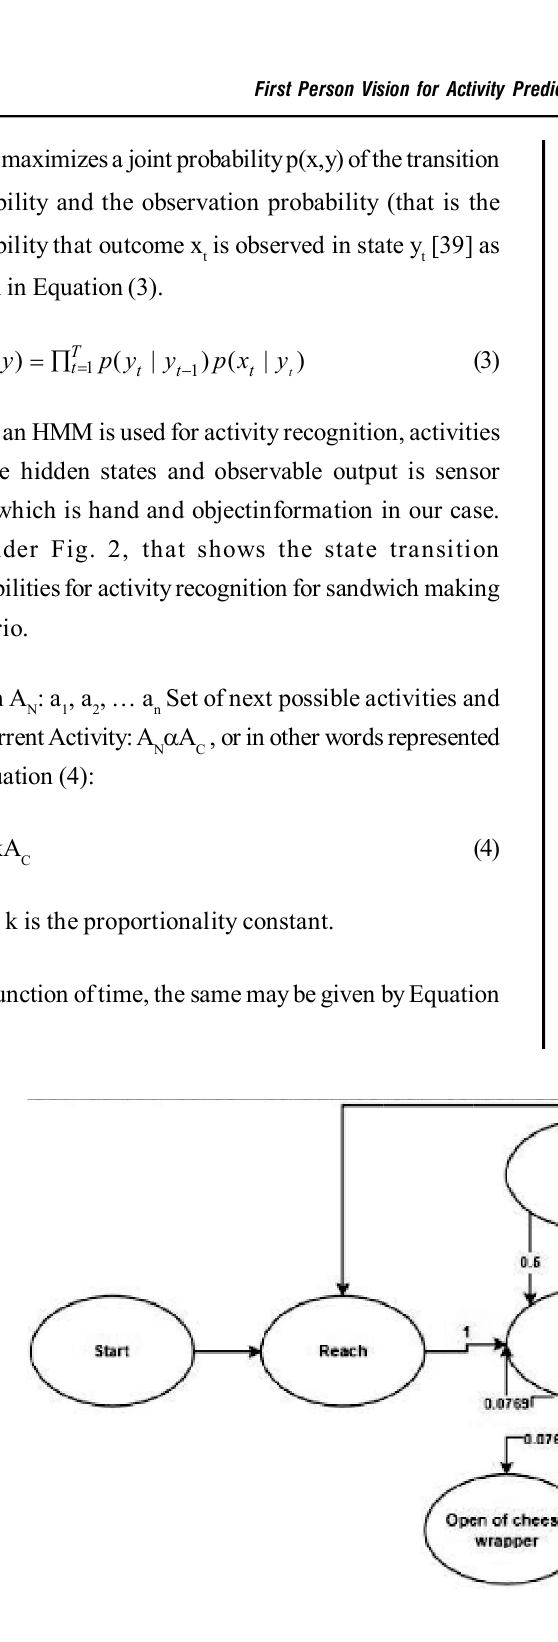
FIG. 2. STATE TRANSITION GRAPH FOR ACTIVITIES IN SANDWICH